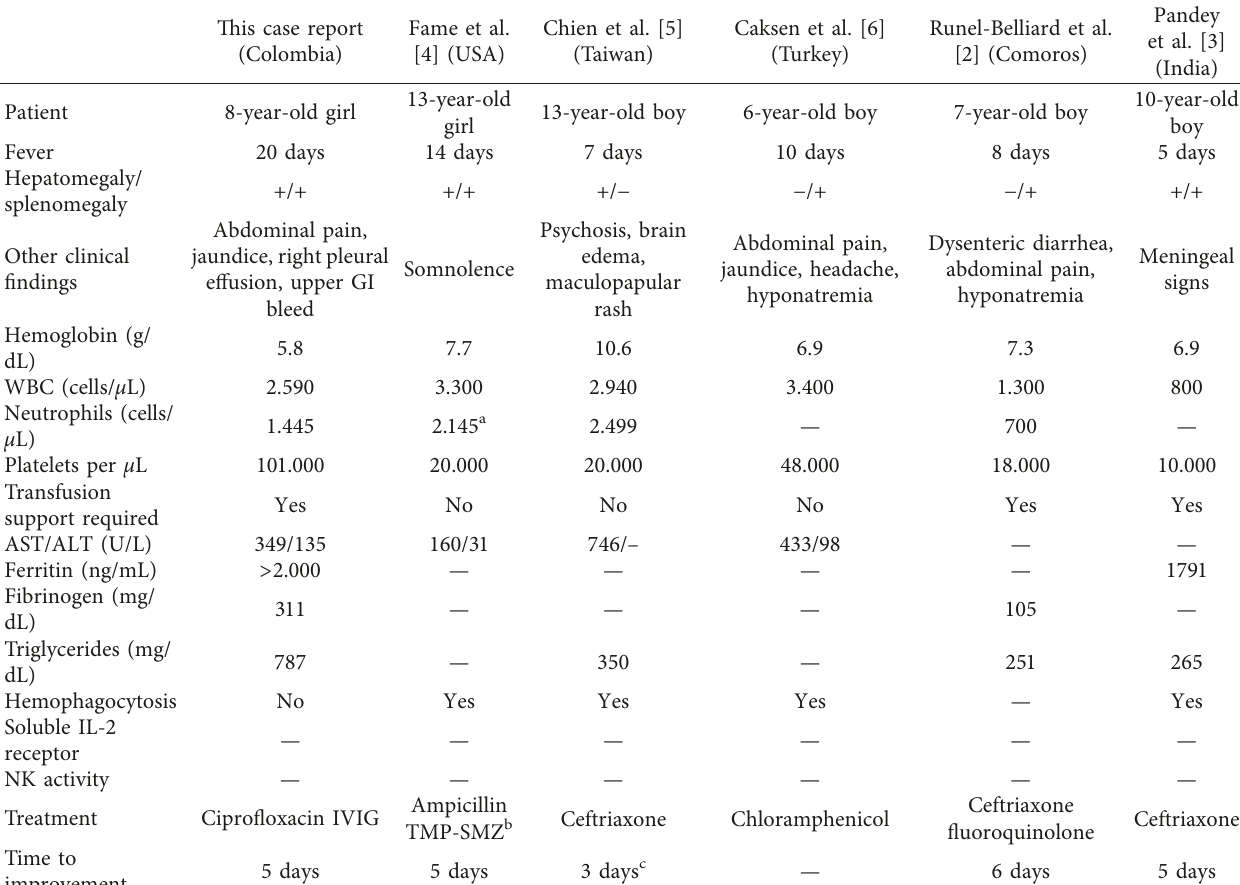
Table 1: Characteristics or reported pediatric cases of HLH secondary to typhoid